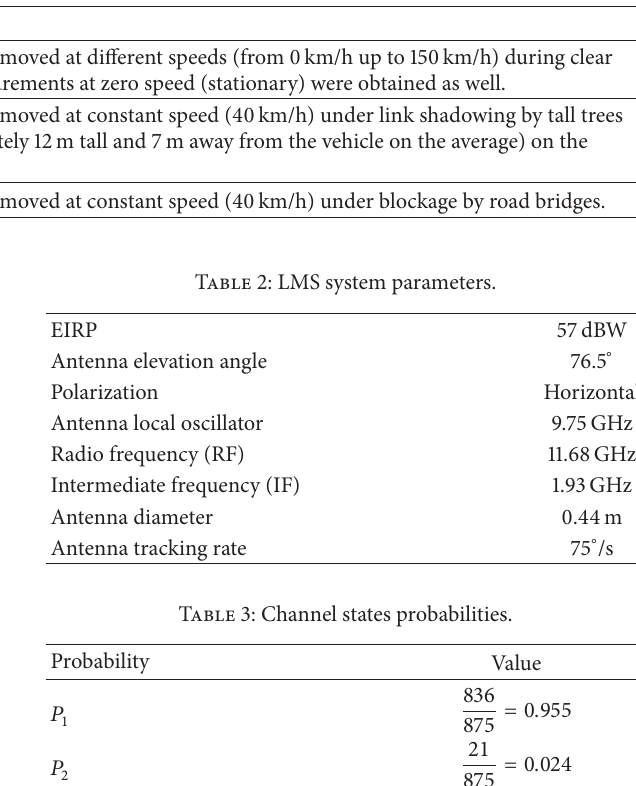
Table 1: Measurements scenarios.